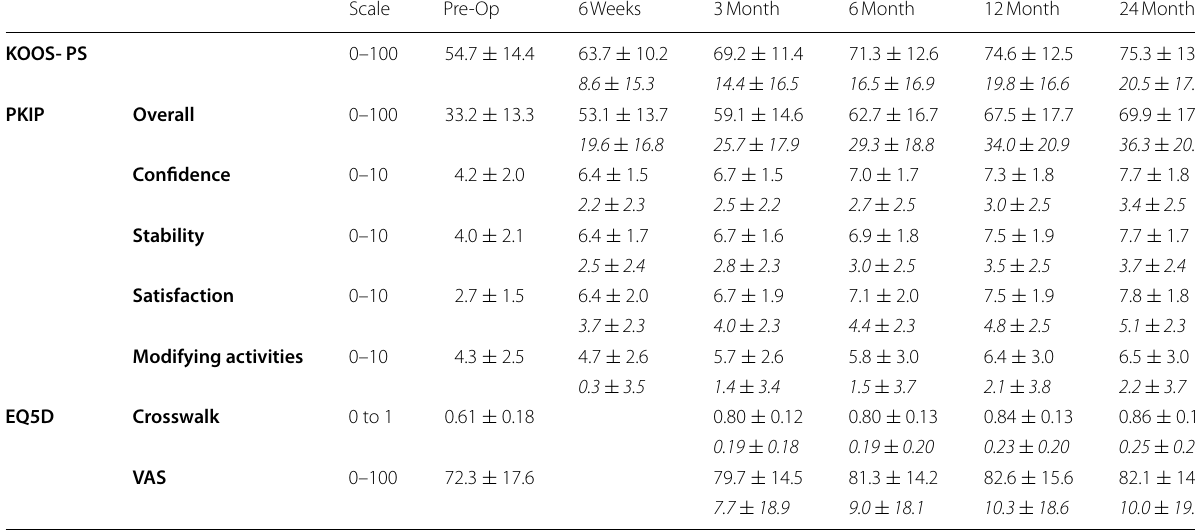
Table 2 PROMs results mean